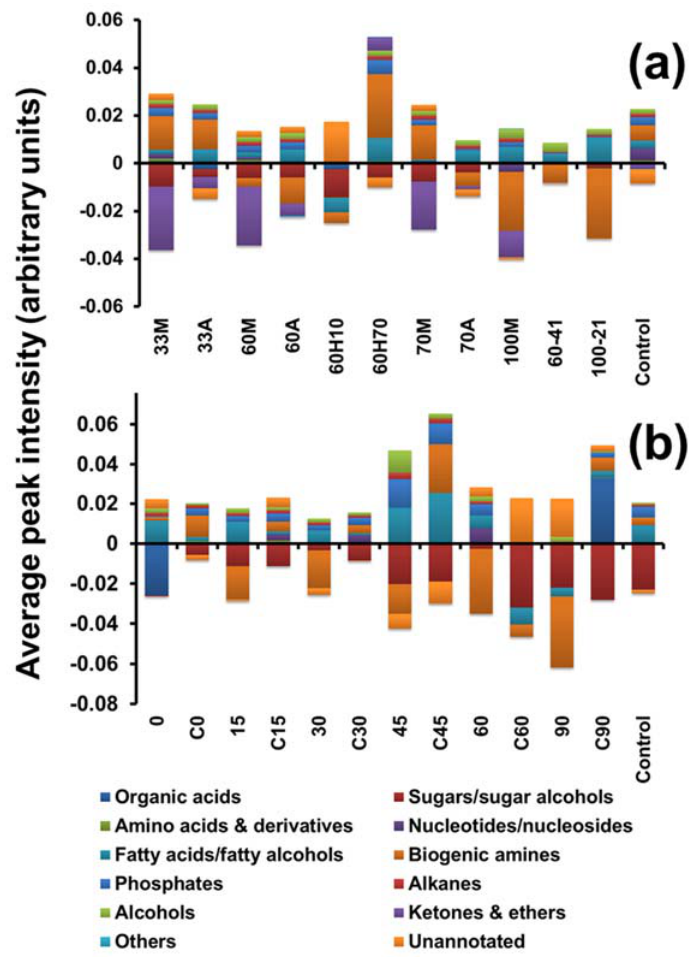
Figure 5. Difference in the average peak intensities of metabolites between cell extracts and